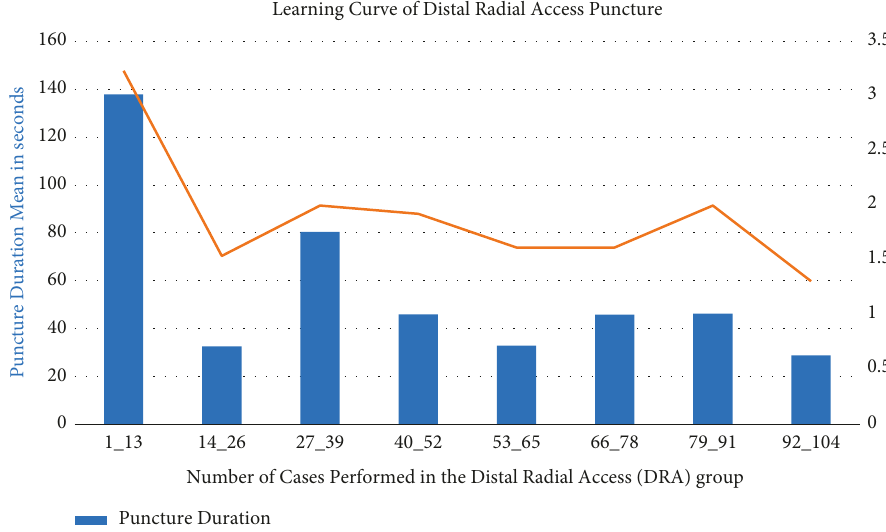
Figure 4: Learning curve of distal radial access